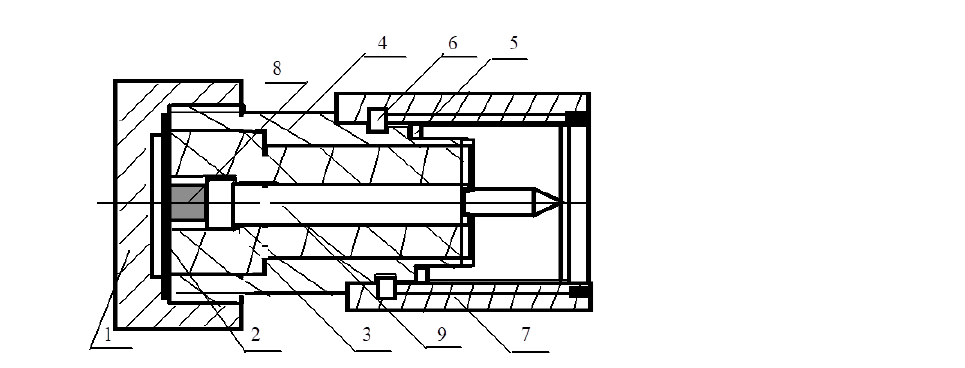
Figure 6. Scheme of coaxial matched load. 1. Lid. 2. Washer. 3. Insulator (PTFE F-4, ε = 2). 4. Body.